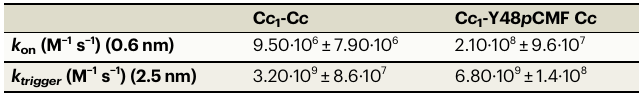
Table 2 | Analysis of brownian dynamics (BD) simulations for the C c 1 -C c